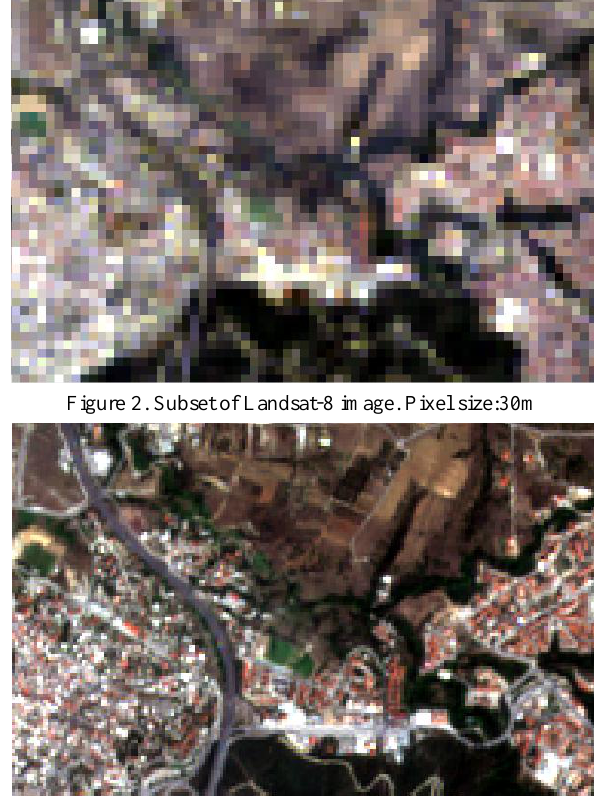
Figure 3. Subset of Sentinel-2A image. Pixel size:10m